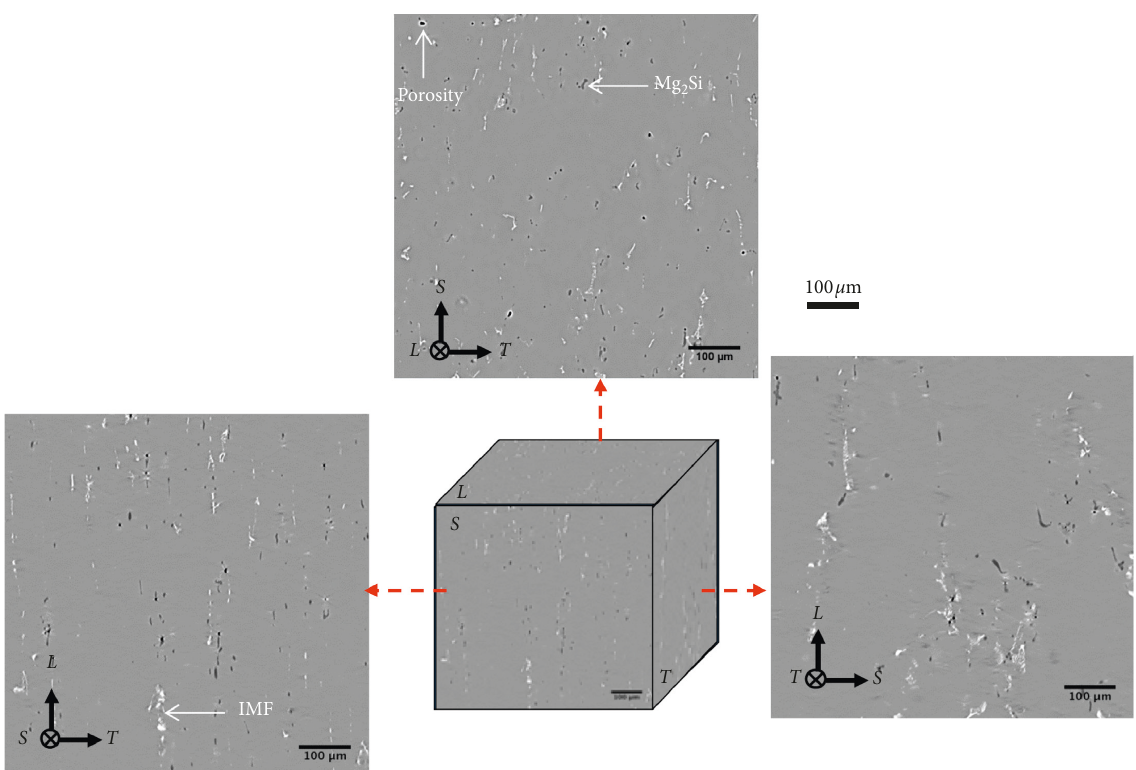
Figure 2: Reconstructed 2D images obtained by SRCT showing the microstructure of the as-received material.